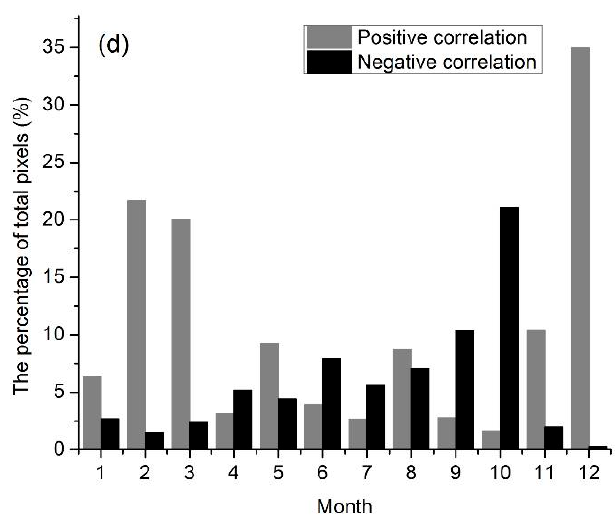
Figure 7. Correlations between the SOS and temperature and between the SOS and precipitation from July of the previous year to June of the same year and correlations between the EOS and temperature and between the EOS and precipitation from January to December of the same year ( a ) SOS-Temperature; ( b ) SOS-Precipitation; ( c ) EOS-Temperature; and ( d ) EOS-Precipitation).